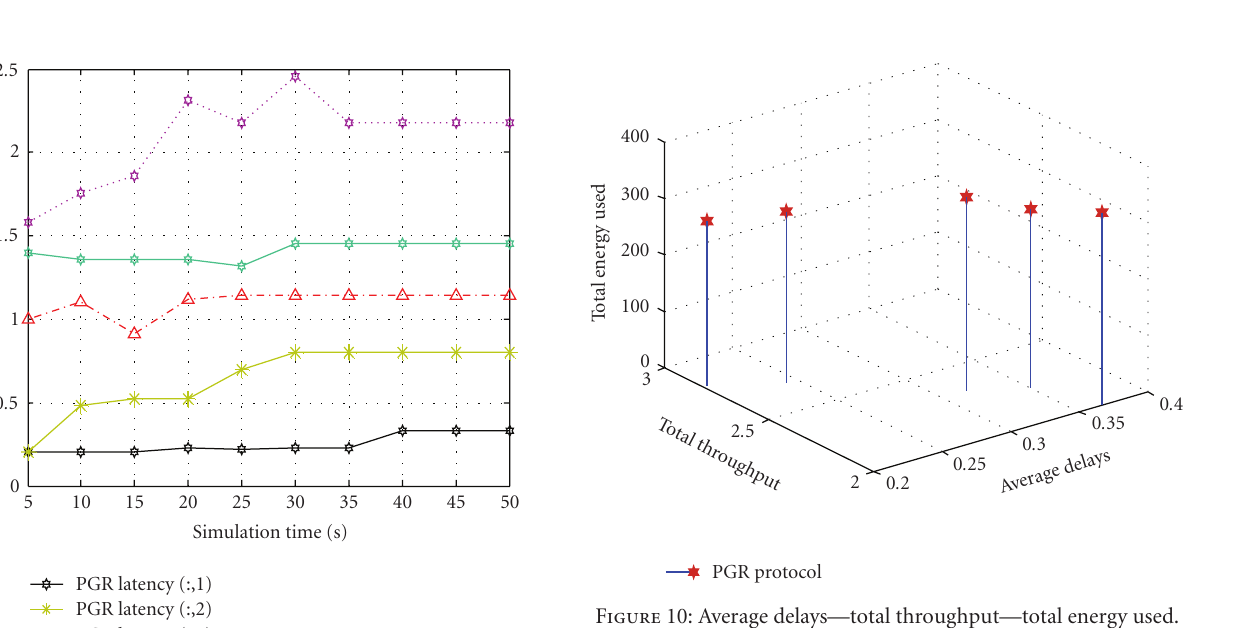
Figure 9: Simulation time and throughput.